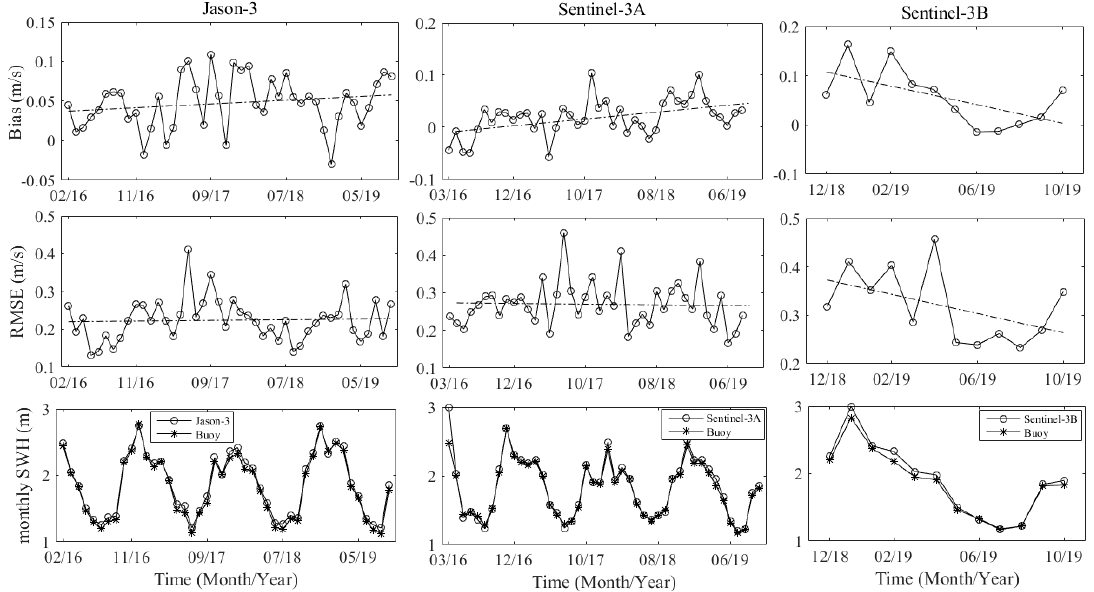
Figure 12. Monthly RMSEs and biases of SWH differences between the Sentinel-3A/3B and Jason-3 altimeters and the NDBC buoys across different months and the average monthly SWH of the collocated data. the dotted straight lines represent the fitting trends.